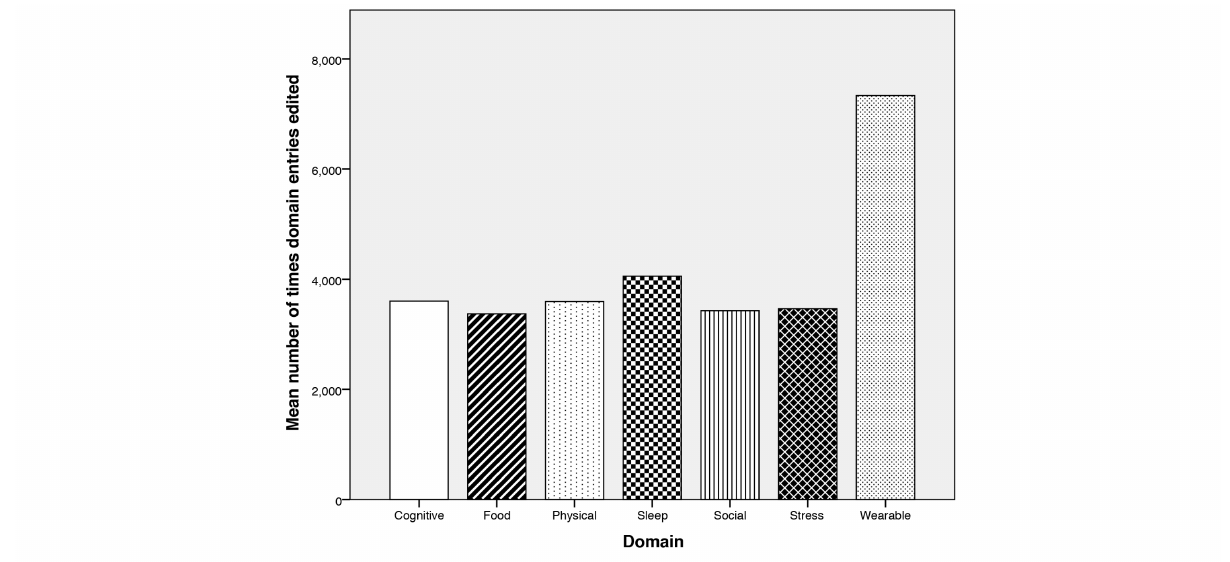
Figure 6. Bar graph showing the mean number of times each domain’s questions were edited using the sliders in the log screen, using updated analytical code, from week 18 to study end. The wearable domain is updated almost twice as often as the other domains.